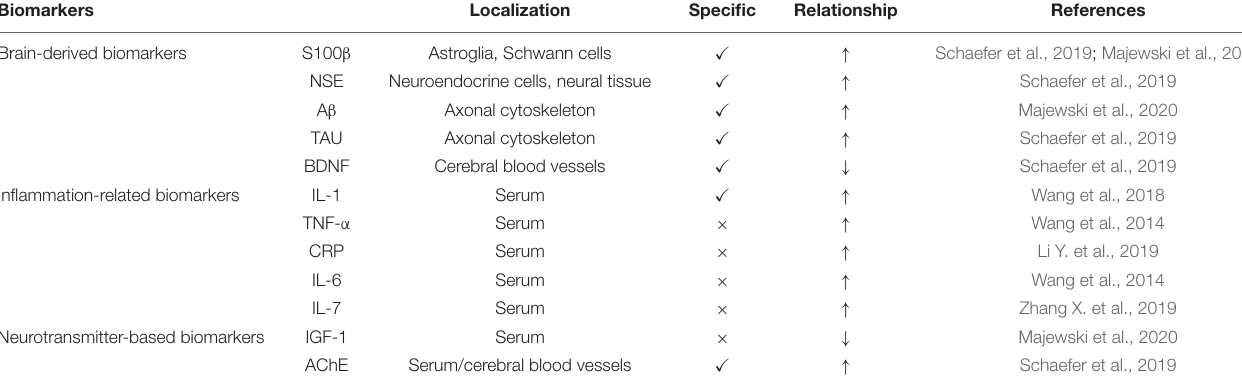
TABLE 1 | Reported biomarkers of postoperative cognitive